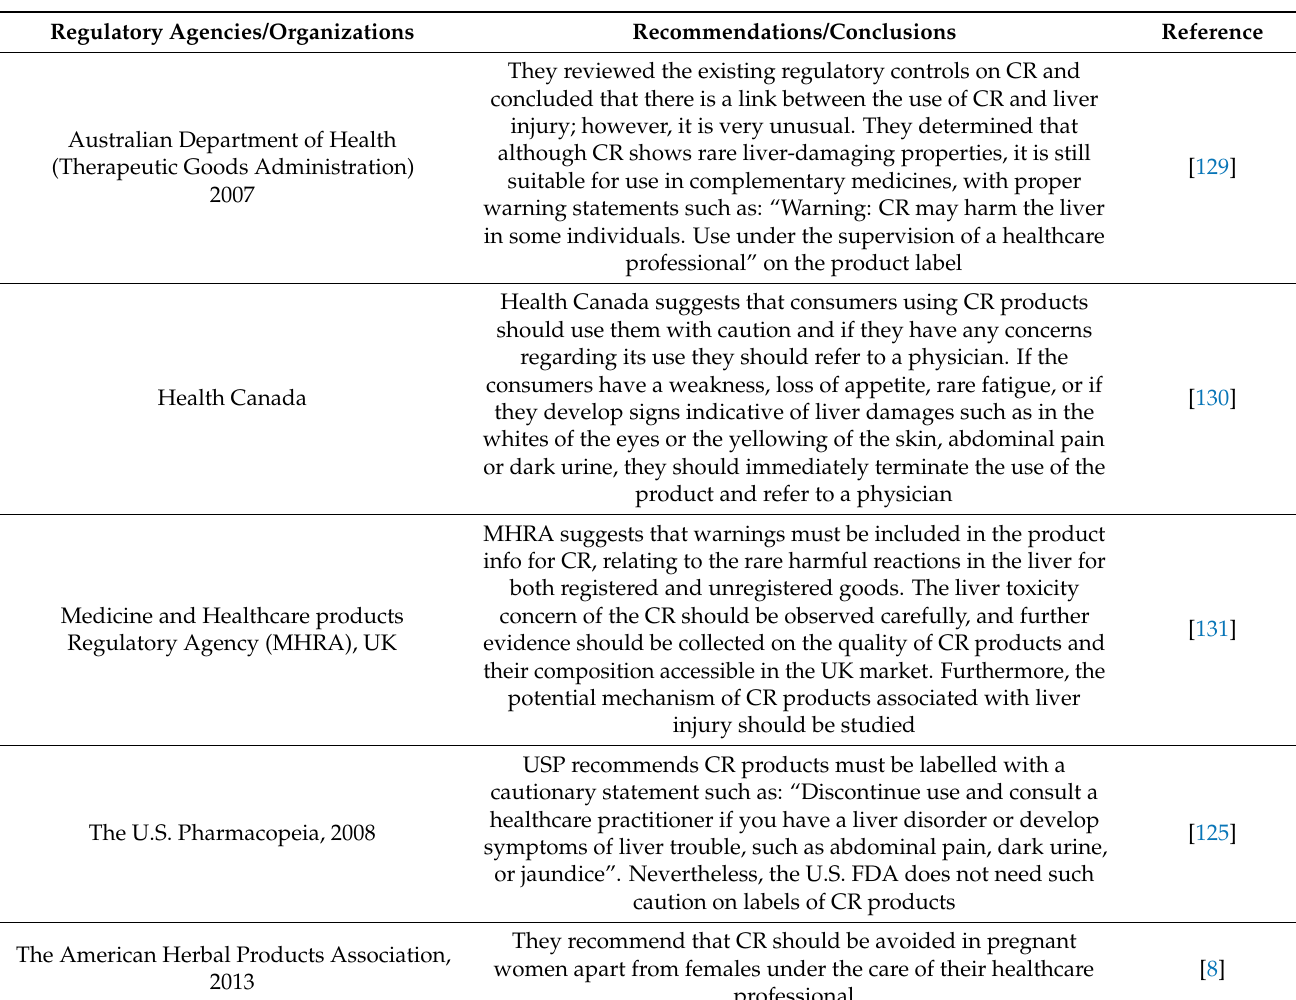
Table 8. Viewpoints of different regulatory agencies/professional bodies regarding liver toxicity relating to